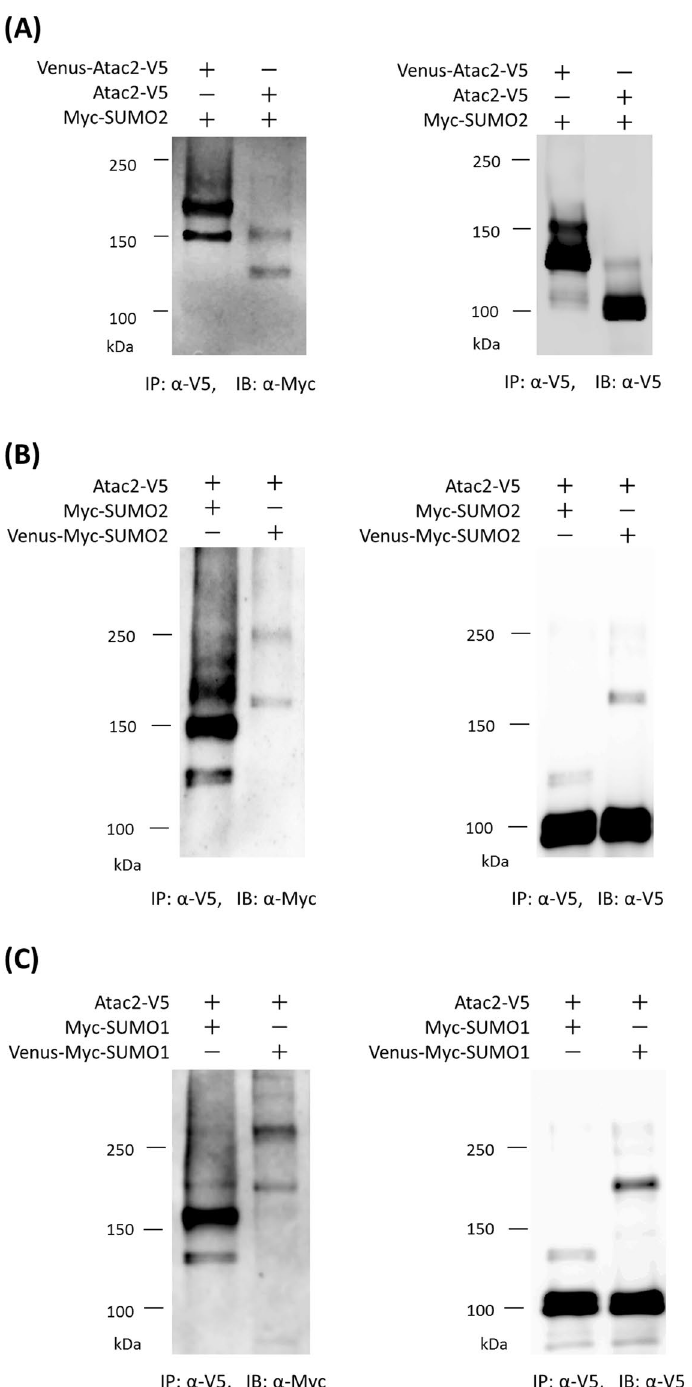
Figure 8. Further analyses of Atac2 SUMOylation. ( A ) Change in Atac2 size to examine the origin of the unknown Myc-SUMO2 proteins that were detected at approximately 150 kDa. NIH3T3 cells transfected with the indicated plasmids were immunoprecipitated with the indicated antibodies. The obtained samples were immunoblotted with the indicated antibodies. ( B ) Evaluation of further modification of monoSUMOylated Atac2 by Myc-SUMO2 molecules by changing SUMO2 size. NIH3T3 cells were transfected with Atac2-V5 in the presence of Myc-tagged SUMO2 or Venus-fused Myc-SUMO2 and subjected to immunoprecipitation with anti-V5 antibodies. The immunoprecipitated proteins were resolved by SDS-PAGE and analyzed by Western blotting with the indicated antibodies. ( C ) Analysis of SUMO1 modification of Atac2. NIH3T3 cells were transfected with Atac2-V5 in the presence of Myc-tagged SUMO1 or Venus-fused Myc-SUMO1 and subjected to immunoprecipitation with anti-V5 antibodies. The immunoprecipitated proteins were subjected to Western blotting with the indicated